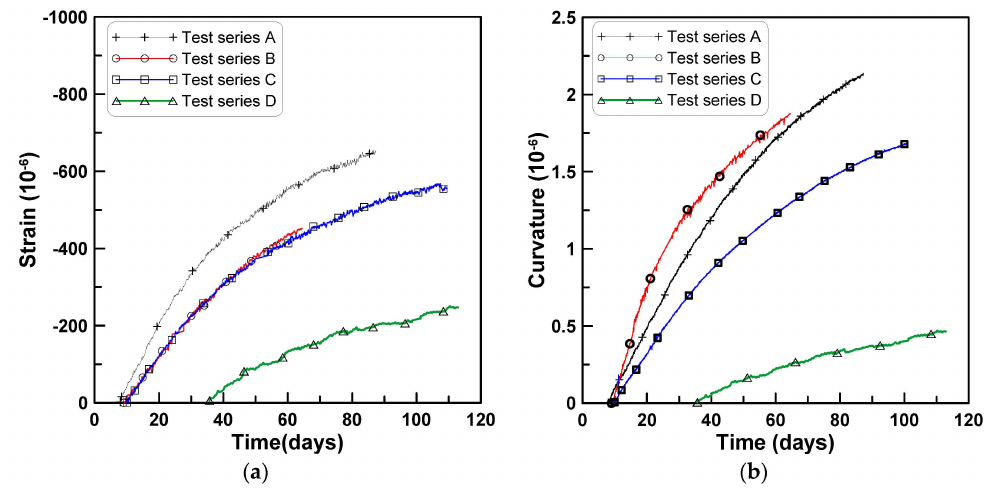
Figure 6. Uniform shrinkage and curvature for four test series: ( a ) Uniform part strain; ( b ) skewed part